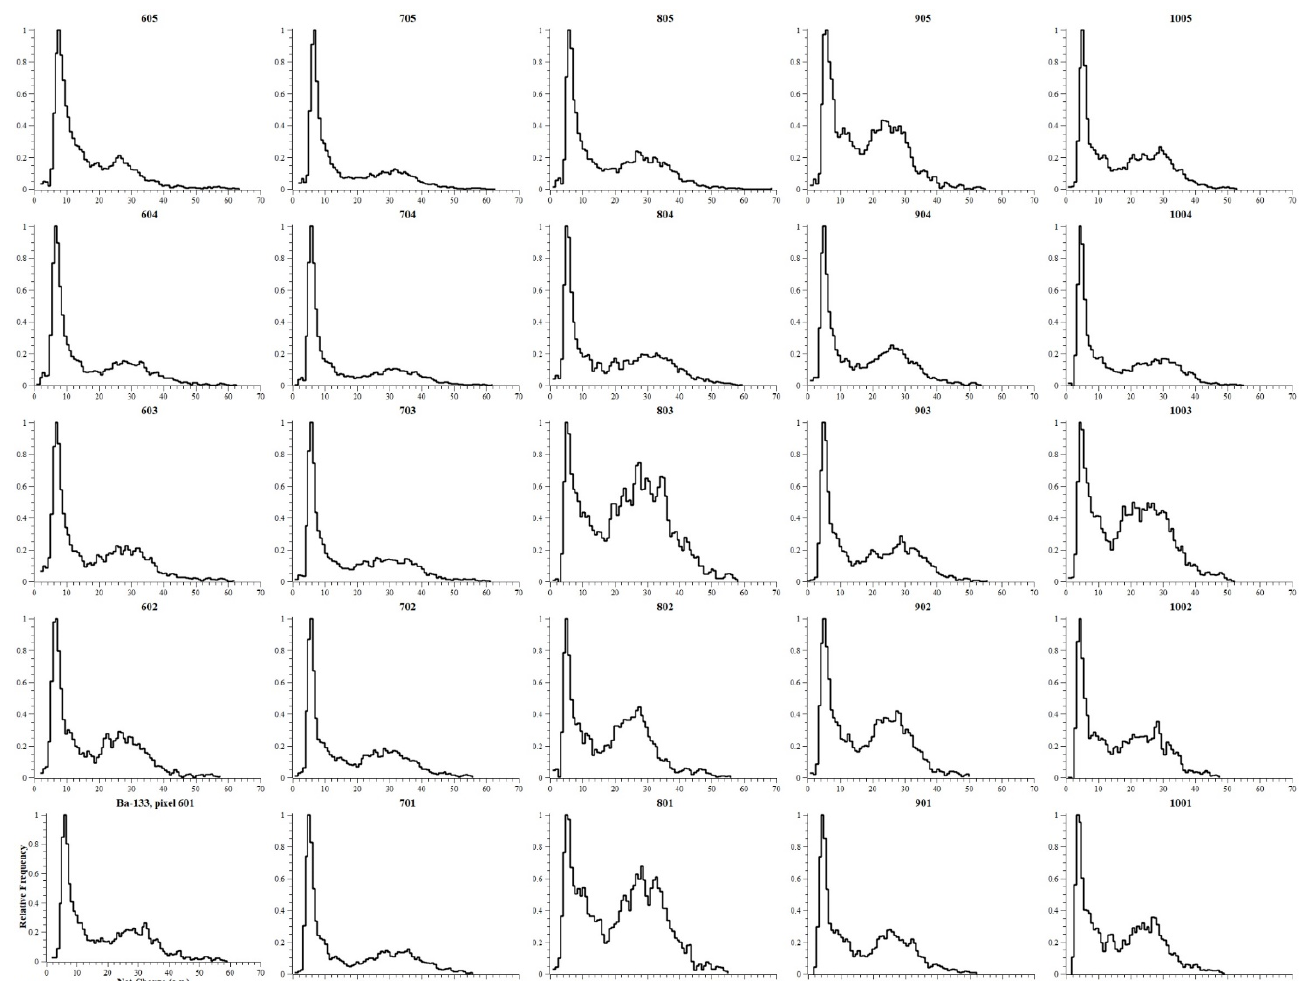
Figure A2. Ba-133 pulse-height spectra per crystal-pixel for the third quarter of the array which includes the pixels with RR > 5 and CC ≤ 5. The common axes and plot descriptions are shown only once in the bottom-left frame for better clarity. Spectra have undergone denoising smoothing, and were built by using 0.75 ch.u. binning. Frequency values were normalized, pixel by pixel, to the respective maximum value.